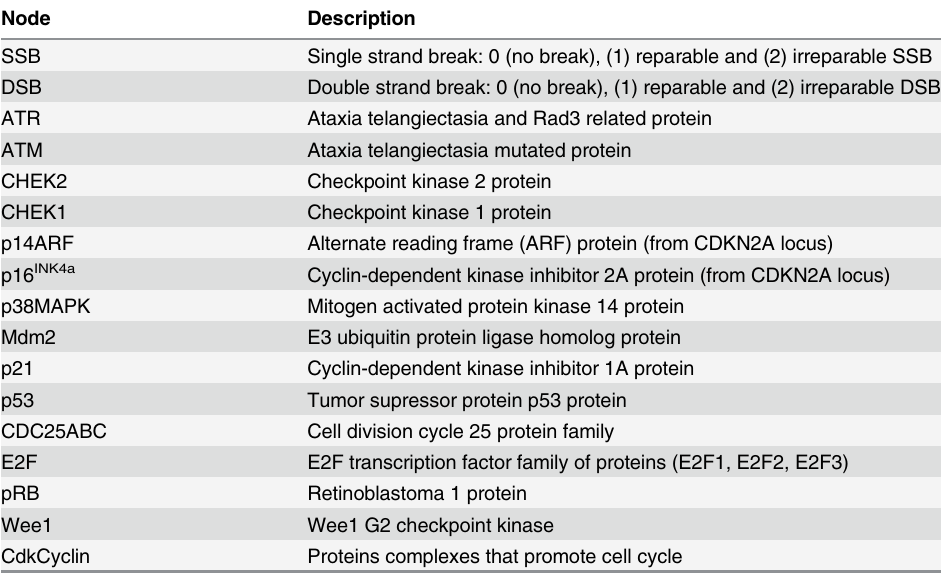
Table 1. Description of network